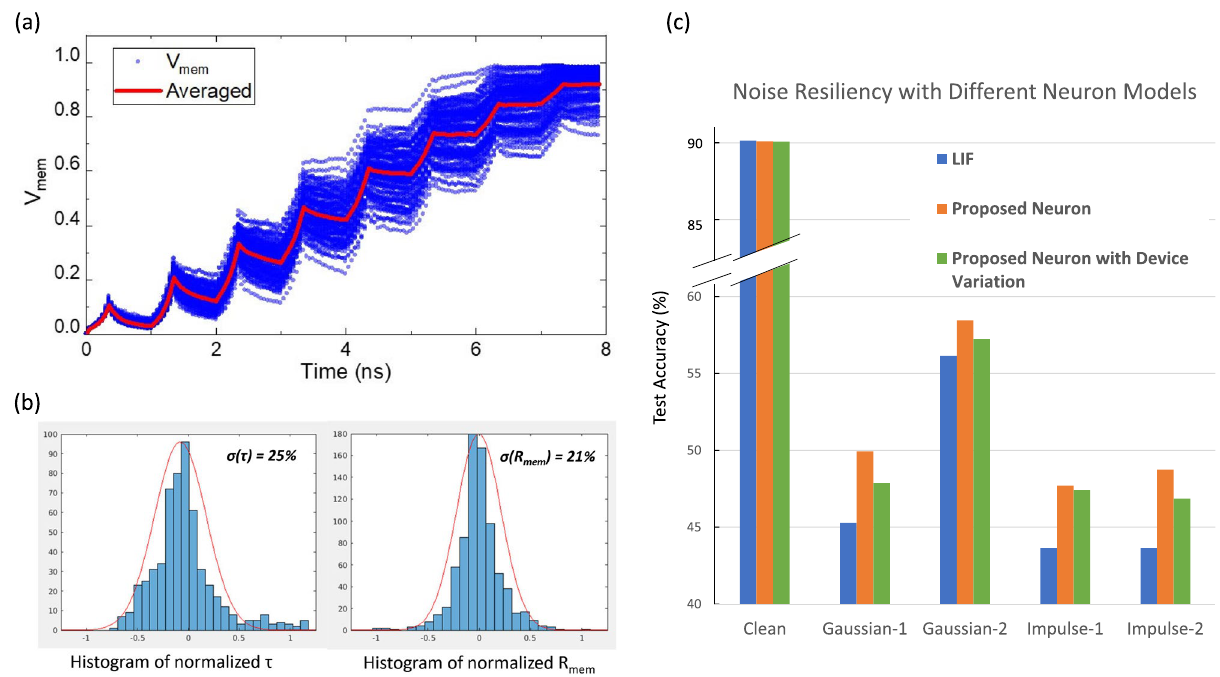
Figure 7. Noise Resiliency of Neuron Models with non-ideal device variations. ( a ) Traces of membrane potential accumulation under input spikes for 100 runs with different initialization of the multi-granular configuration. ( b ) Statistics of the model parameters under device variation. ( c ) Summary of SNN model performance in presence of device variation in comparisons with baseline